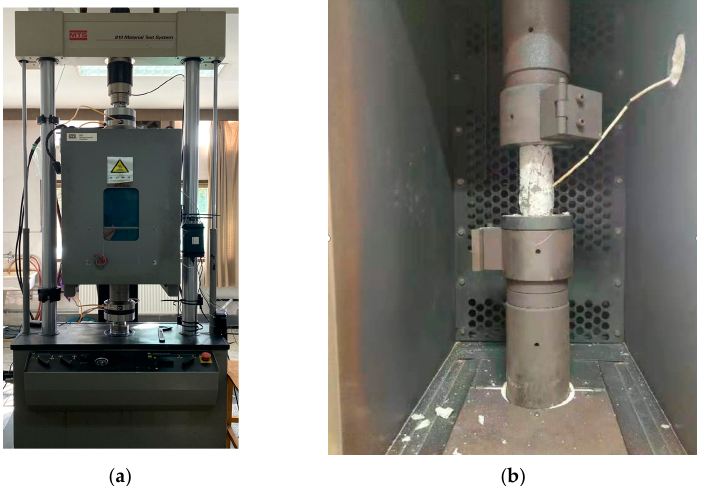
Figure 4. ( a ) MTS 810 test system’s installed heating chamber, ( b ) the interior of the heating chamber.